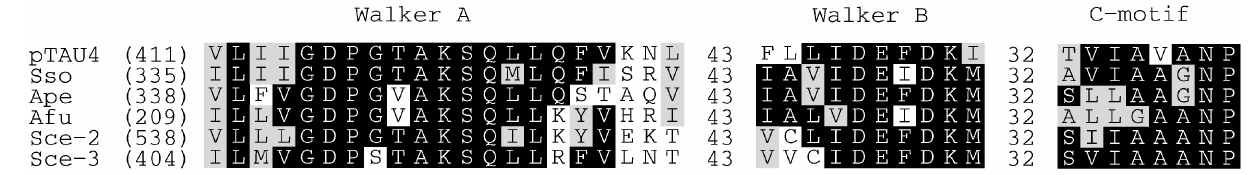
Figure 3. Alignments of Walker A and Walker B motifs and the C-motif of the mini-chromosome maintenance (MCM) protein of pTAU4 with those encoded in the archaeal chromosomes of S. solfataricus (Sso), A. pernix (Ape) and Archaeoglobus fulgidus (Afu), as well as the Saccharo- myces cerevisiae MCM2 (Sce-2) and MCM3 (Sce-3) proteins. Identical and similar amino acids are indicated by black and gray boxes, respec- tively, obtained with Boxshade (see Figure